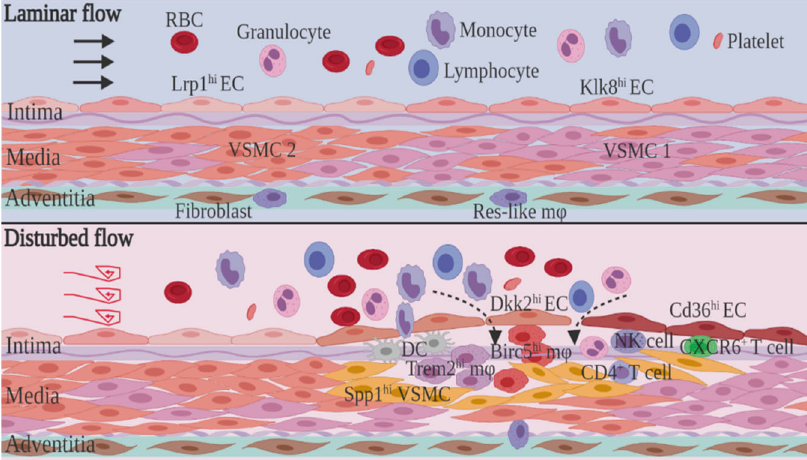
Fig. 7 A proposed model for the cellular heterogeneity of mouse carotid artery under d- fl ow. In normal carotid arteries that blood fl ow was laminar and parallel to the blood vessel, endothelial cell subpopulations were Klk8 hi ECs and Lrp1 hi ECs, while smooth muscle cells were VSMC1 and VSMC2 clusters. When exposed to d- fl ow, the heterogeneity of vascular wall cells was changed compared with normal carotid arteries. New subpopulations, such as Dkk2 hi ECs, Cd36 hi ECs, and Spp1 hi VSMCs, were emerged. Among the in fi ltrating cell subpopulations, Trem2 hi M φ , Birc5 hi M φ , DCs, CD4 + T cells, CXCR6 + T cells, NK cells, and granulocytes were identi fi ed under d- fl